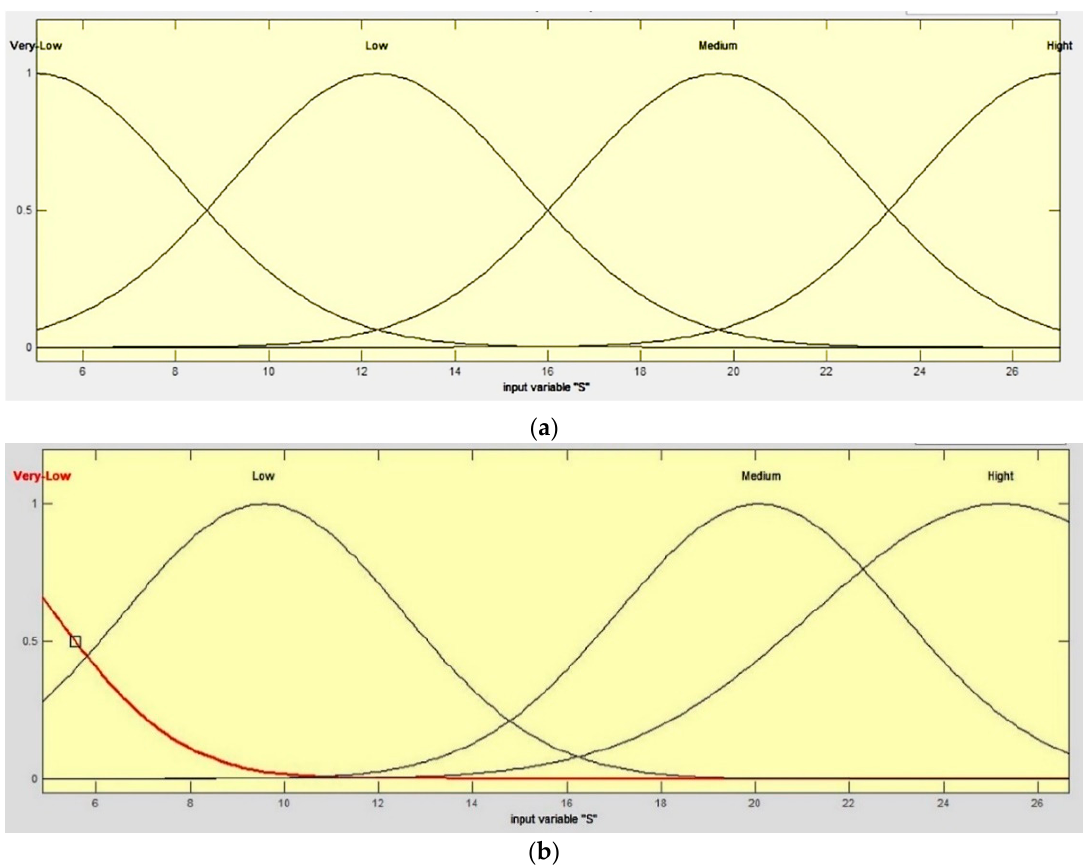
Figure 3. Initial and final membership functions of stone strength ( s ); ( a ) initial, ( b ) final.